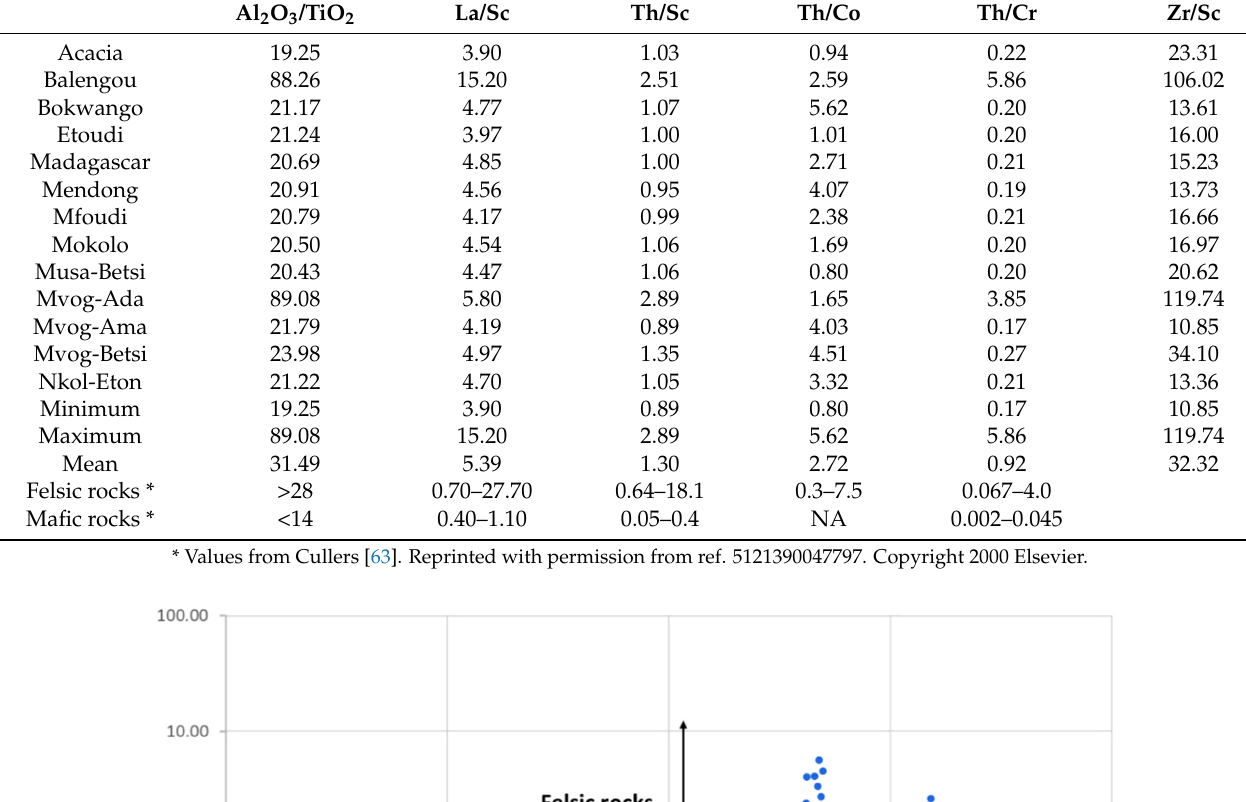
Table 2. Average elemental ratios in studied geophagic clays from Cameroon compared with ratios in felsic and mafic rocks. Al 2 O 3 /TiO 2 La/Sc Th/Sc Th/Co Th/Cr